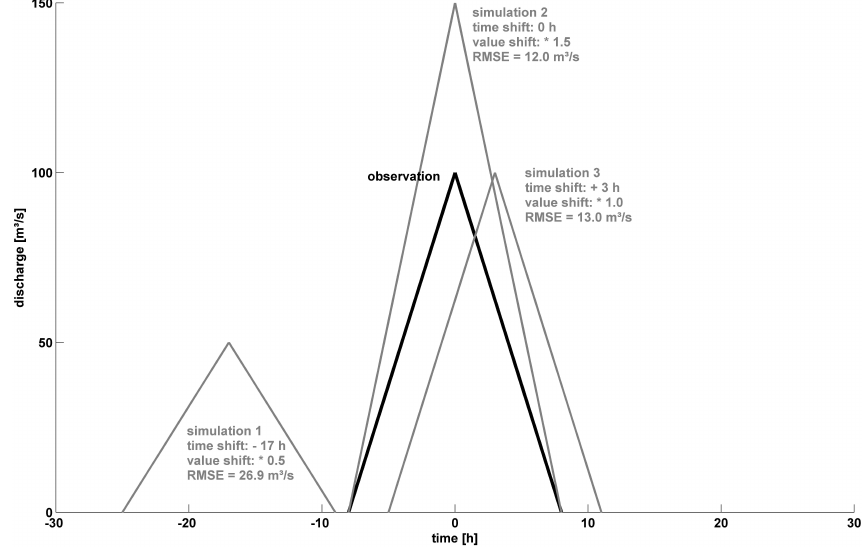
Fig. 1. Synthetic, triangular events. “Observation” (bold line) and three example “simulations” (normal lines) derived from the “observation” by time offsets and multiplicative value offsets.